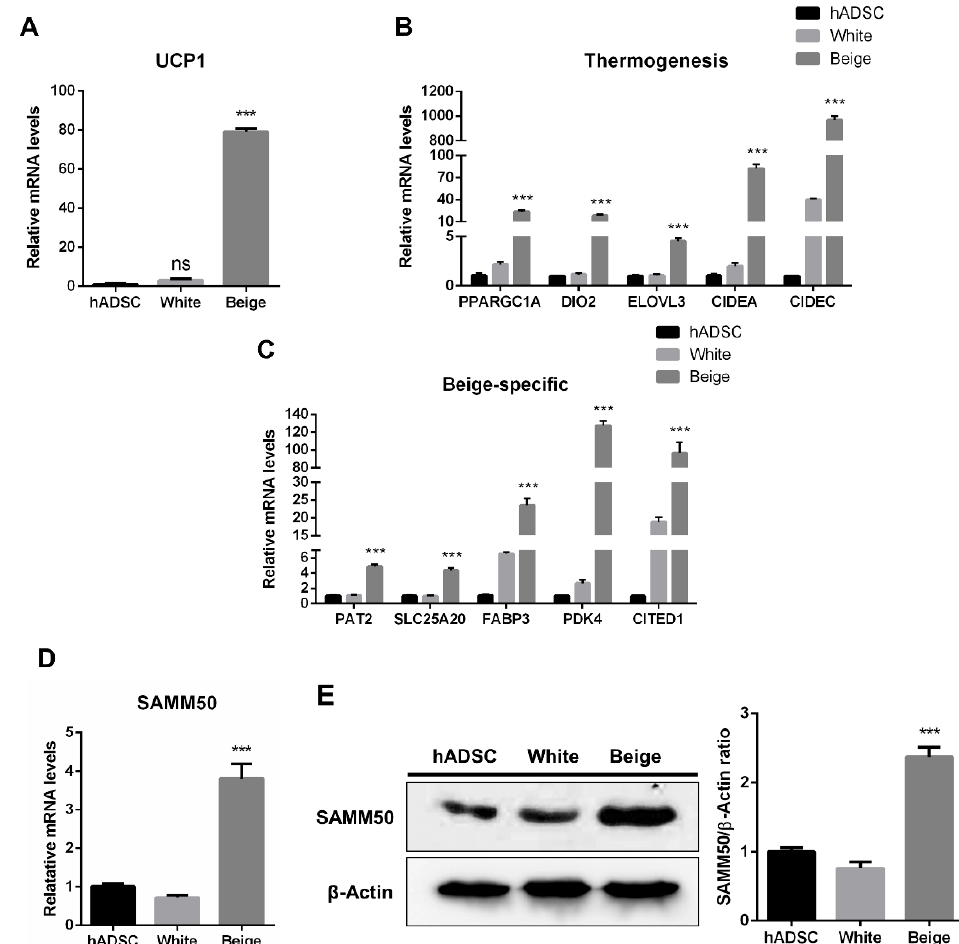
Figure 2. The establishment of beige adipocytes differentiated from human adipose-derived stem cells and SAMM50 expression in beige adipocytes. ( A ) qPCR analysis assessed UCP1 mRNA levels in the human adipose-derived stem cells and differentiated cells. ( B , C ) The expression levels of thermogenic ( B ) and beige-specific ( C ) genes were investigated by qPCR. ( D , E ) qPCR and Western blot analyses were performed to examine mRNA and protein levels of SAMM50 in the human adipose-derived stem cells and the differentiated cells. The protein levels of SAMM50 were quantified using ImageJ software. Results are shown as mean ± SEM. *** p < 0.005 compared to the hADSC and white group.